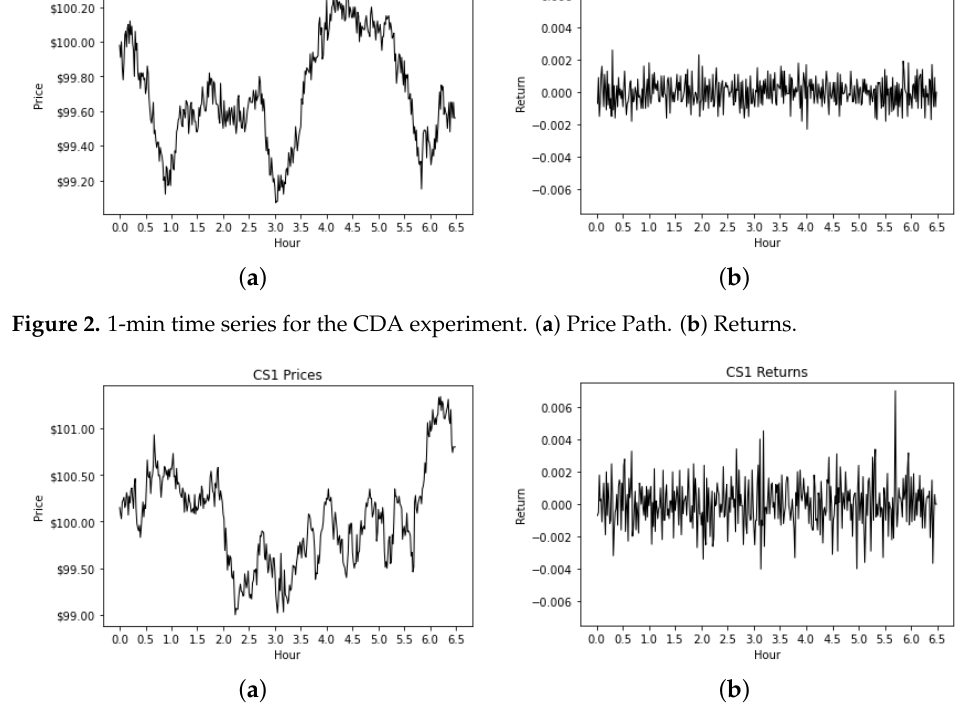
Figure 3. 1-min time series for the HVCDA experiment. ( a ) Price Path. ( b )